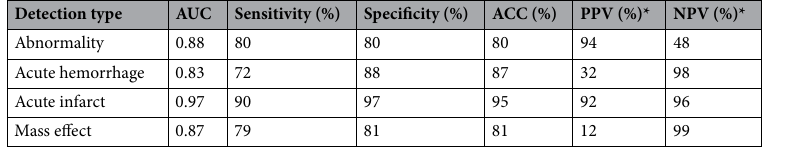
Table 3. Performances of the classifiers on the external test set. *Note that positive predictive value (PPV) and negative predictive value (NPV) are highly dependent on the prevalence of the finding in a given population.